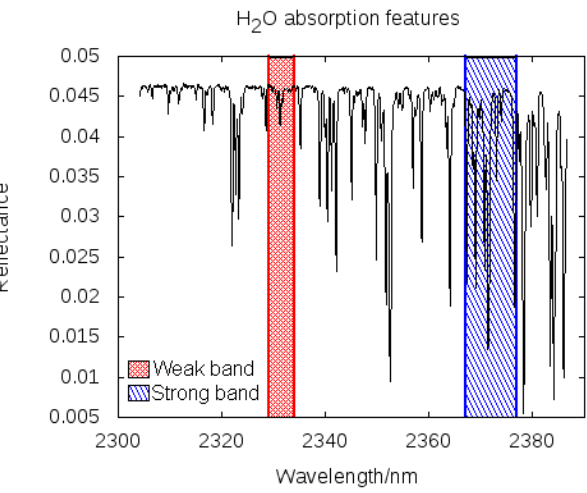
Figure 3. Simulated reflectance spectrum showing the absorption features of H 2 O in the SWIR spectral range for the same scenario as in Fig. 1. The red shaded area represents the weak absorption band, while the blue area represents the strong absorption band of H 2 O. The difference between the water column retrieved from the weak and strong band is used for the backup cloud